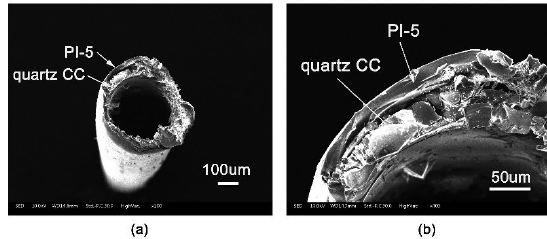
Figure 5. Scanning electron microscope (SEM) images for PI-5-coated CC samples with different magnification times: ( a ) 100 μm; ( b ) 50 μm.